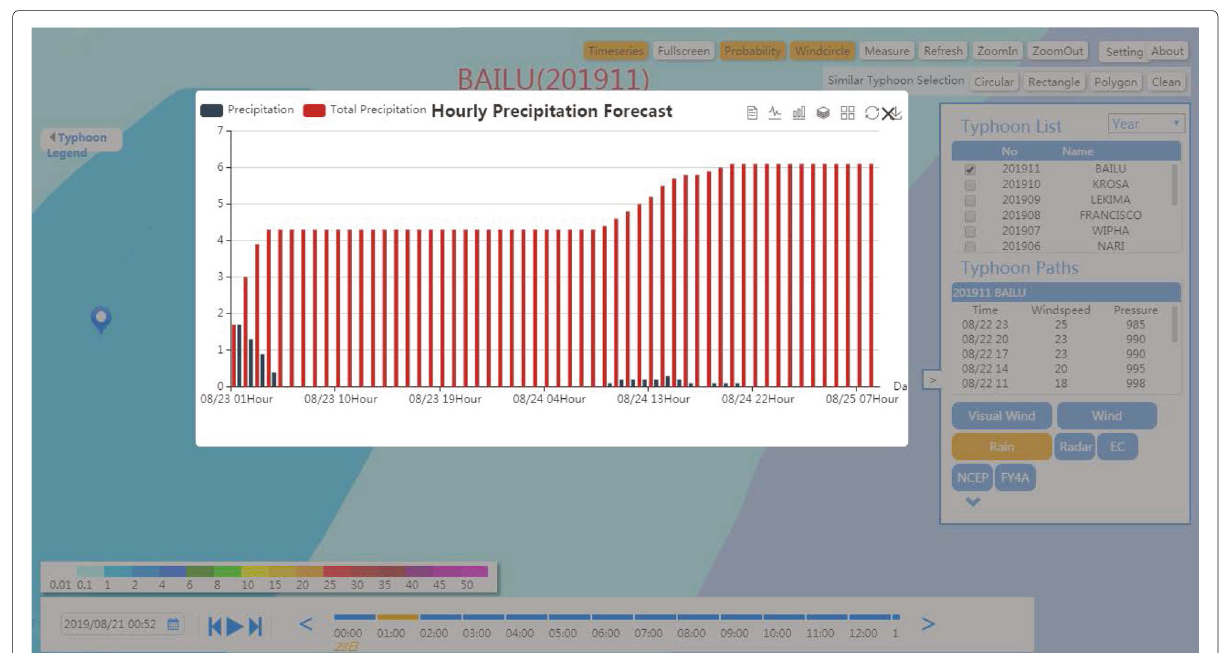
Fig. 12 The application of any latitude and longitude grid time sequence of the rain forecast at 01:00 on August 23, 2019